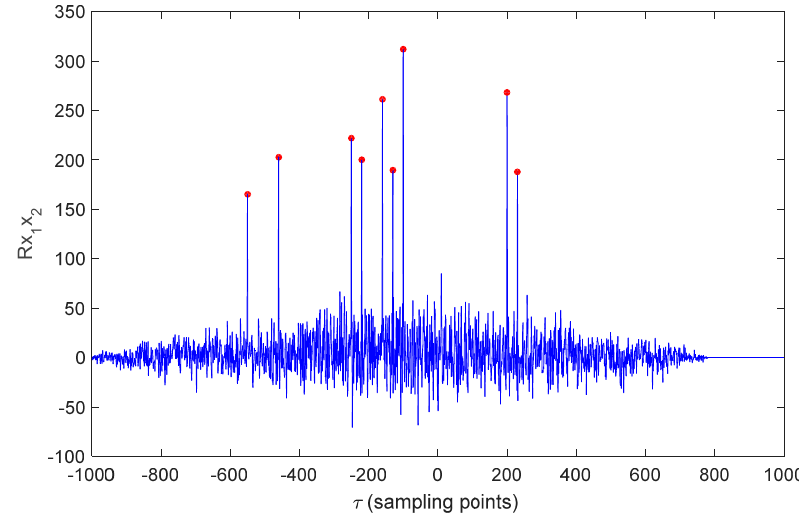
Figure 4. Cross-correlation function of signals .